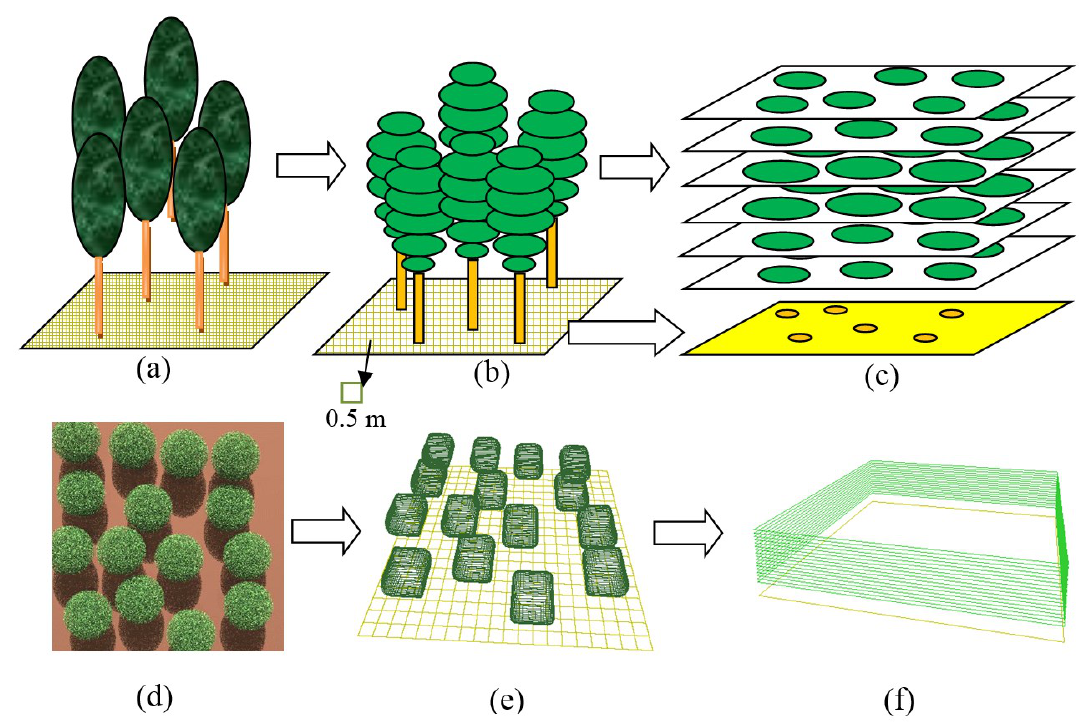
Figure 3. The illustration of 3D scenes using HETOBJs: ( a ) a forest stand with six trees; ( b ) abstraction of the forest in ( a ) using 36 HOMOBJs; ( c ) abstraction of the forest in ( a ) using only 7 HETOBJs; ( d ) a forest stand with 15 trees; ( e ) abstraction of the forest in ( d ) using 300 HOMOBJs; ( f ) abstraction of the forest in ( d ) using only 20 HETOBJs.